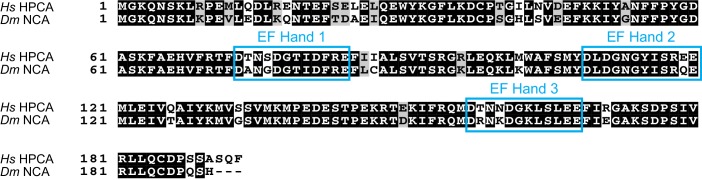
Human Hippocalcin and Drosophila Neurocalcin are highly homologous neuronal calcium sensors.Amino-acid alignment of human Hippocalcin (Hs HPCA) and Drosophila Neurocalcin (Dm NCA) is shown. Blue boxes: location of the calcium-binding EF-hand domains of Hippocalcin and Neurocalcin. Black boxes represent full amino-acid conservation, grey boxes represent functional conservation.